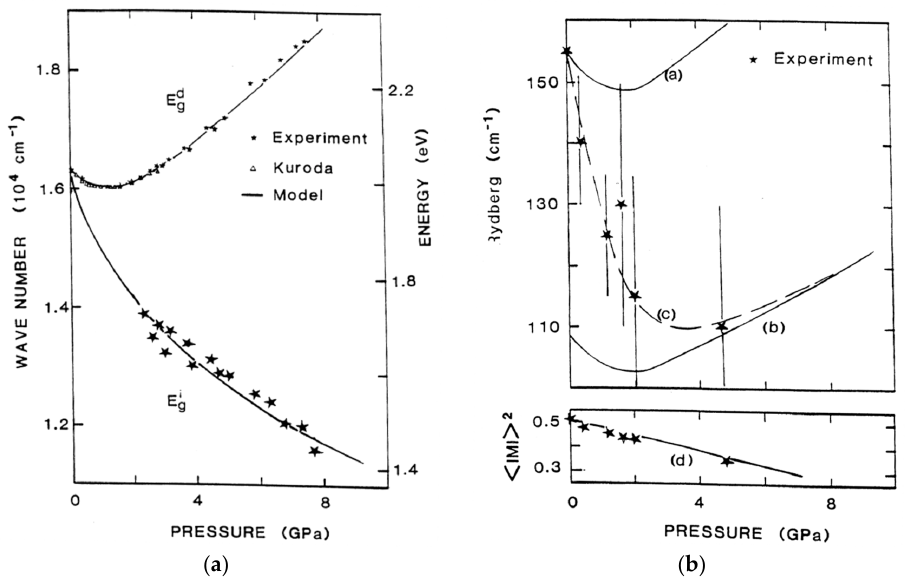
Figure 8. ( a ) Pressure dependence of the direct and indirect absorption edges in GaSe. ( b ) Pressure dependence of effective exciton Rydberg (exciton binding energy) and the dipole matrix element (exciton absorption intensity) in GaSe fundamental edge [57].